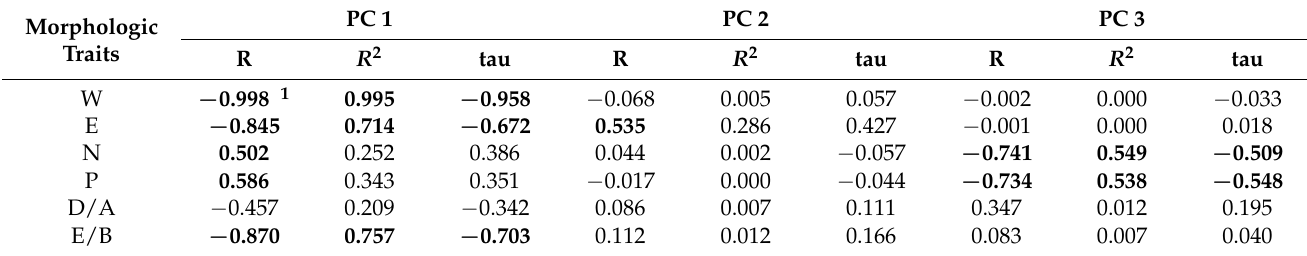
Table 3. Description of three main principal components (PCs) from the PCA on leaf traits with the highest R 2 from the ANOVA. Pearson’s (R) and Kendall’s (tau) correlations with the PCA ordination axes; n =